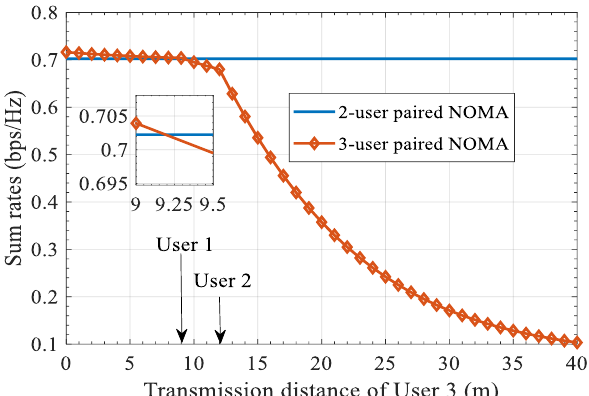
Figure 4. Sum rates of relay-aided UOWC system with two-user paired and three-user paired NOMA.